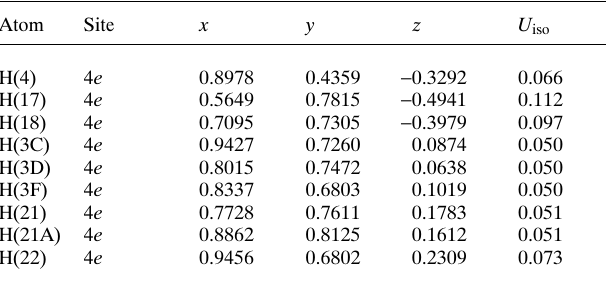
Table 2. Atomic coordinates and displacement parameters (in Å 2 ) .